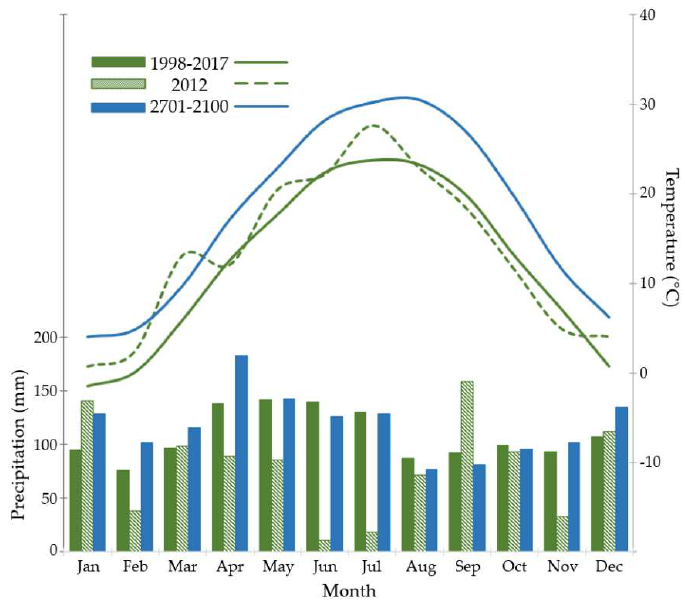
Figure 1. Climate diagram for Lilly–Dickey Woods. Bars represent precipitation and lines represent temperature, for average conditions observed 1998–2017, the drought year 2012, and projected for 2071–2100. Annual precipitation was 949 mm in 2012, but averaged 1296 mm during 1998–2017; average annual precipitation was projected to increase to 1416 mm during 2071–2100. Recent climate data from PRISM data sets, which were projected for future conditions [39] as described in text.